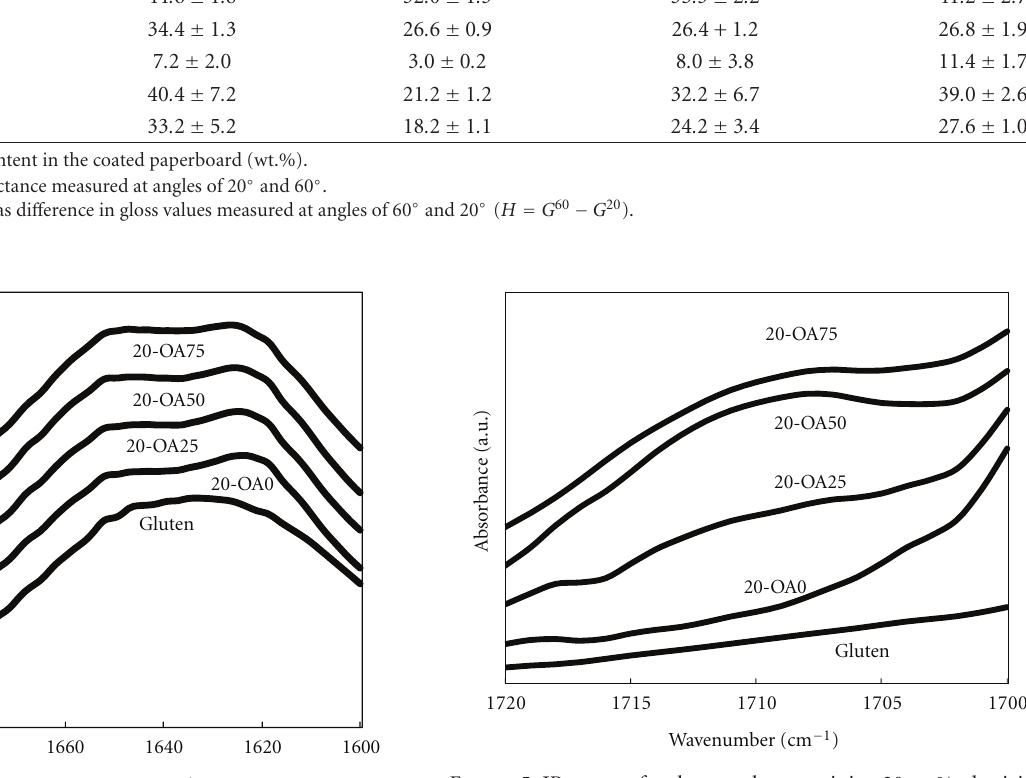
Figure 5: IR spectra for the samples containing 20wt.% plasticizer in the ester region. The notations are the same as in Figure 4. For clarity the curves have been shifted vertically. Gluten refers to unprocessed wheat